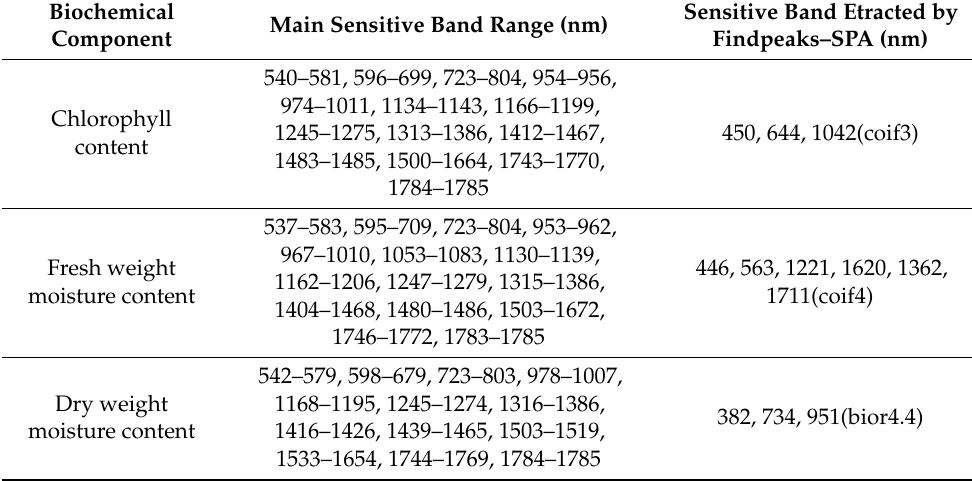
Table 6. Sensitivity analysis results obtained by using Pearson–Findpeaks–SPA. Biochemical Main Sensitive Band Range (nm) Component